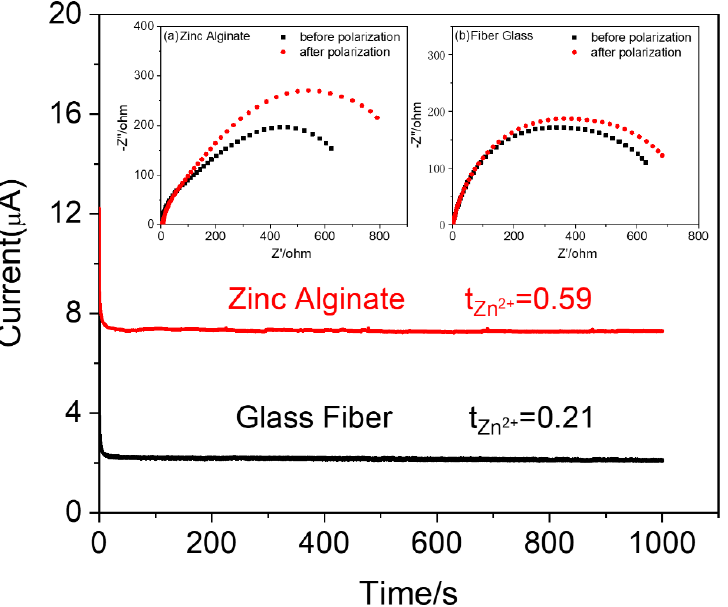
Figure 5. Chronoamperometry profiles for Zn/ZA-based HGPE/Zn and Zn/wet glass-fiber separa- tor/Zn cells. Insets are impendence plots of ( a ) Zn/ZA-based HGPE/Zn and ( b ) Zn/wet glass-fiber separator Zn cells before and after polarization.